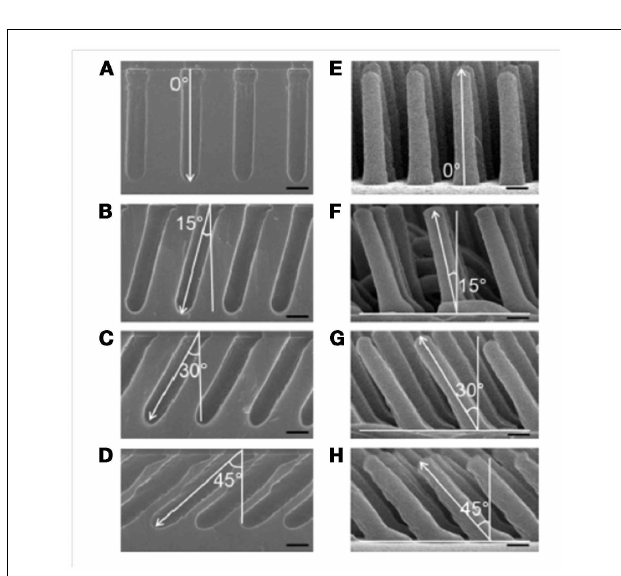
FIGURE 6 | Sample fabrication processes for (A) one-layer structure and (B) two-layer (hierarchical) structure using one and two membranes in the stack, respectively . After heating the stacks in an oven, the membranes